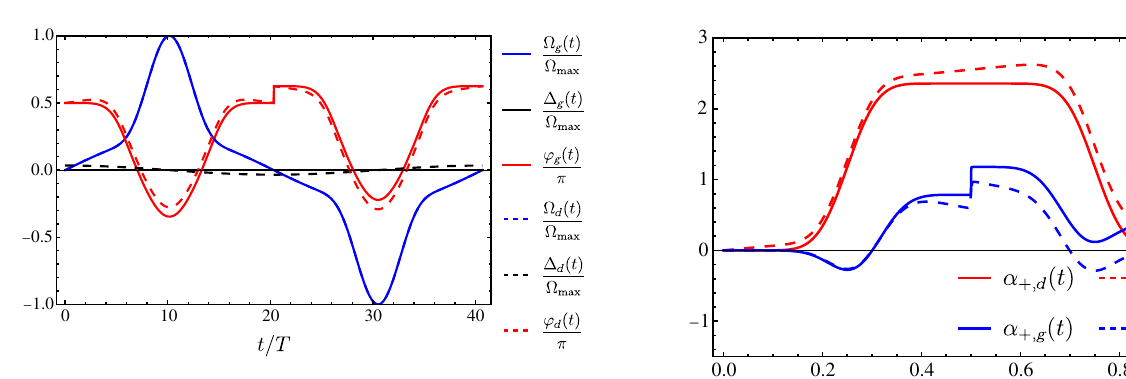
FIG. 7. A plot of the control parameters that generate a Z π/ 4 or T gate. The subscript “ g ” (“ d ”) denotes the control parameters that generate a geometric (dynamical) gate. The values are nor- malized by (cid:11) max , which denotes the maximum value of (cid:11)( t ) . We note again that (cid:11) g ( t ) = (cid:11) d ( t ) and that (cid:13) d ( t ) is nontrivial.